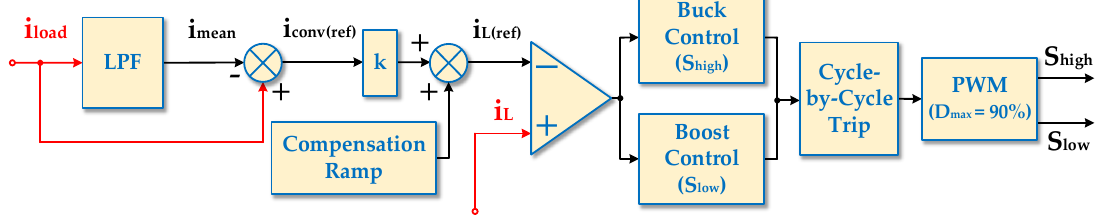
Figure 5. Block diagram of the proposed control scheme.